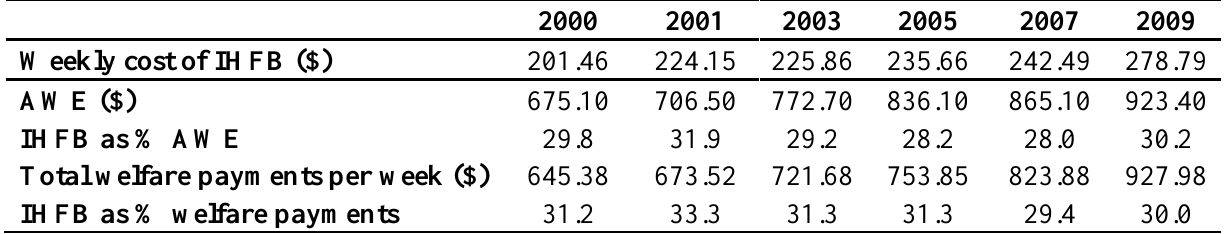
Table 1. The cost of the Illawarra Healthy Food Basket in Australian dollars compared with average weekly earnings * and welfare payments ** 2000–2009.